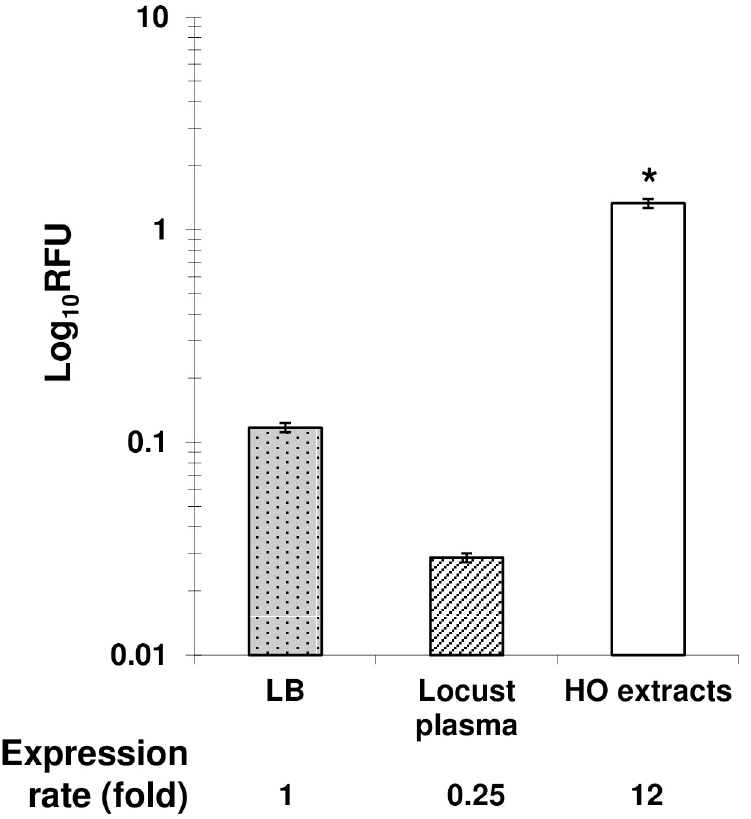
Fig 6. Level of expression of Photorhabdus luminescens mdtABC operon in Locusta migratoria plasma and medium containing HO extract in vitro . Overnight cultures of P . luminescens carrying the P [AAV] fusion mdtA -gfp were diluted (1/500) in black-sided clear-bottomed 96-well plates containing one of the following media: fresh LB medium, plasma or fresh LB medium supplemented with L . migratoria HO extract. A 600nm and GFP fluorescence were monitored, in real time, in triplicate for each set of conditions, at 28˚C, with orbital shaking, in an Infinite M200 microplate reader (TECAN). Specific fluorescence was obtained by dividing GFP fluorescence units (FU) by the A 600nm value at 20 hours of growth. Relative Fluorescence Units (RFUs) were determined by the ratio of the P mdtA - gfp - gfp [AAV]. Asterisks indicate statistically significant differences ( � , [AAV] specific fluorescence value to that of the P lac P < 0.05) in the paired Student’s t test. The expression rate is the ratio between specific activity obtained after incubation with HO extracts and that obtained after incubation with insect